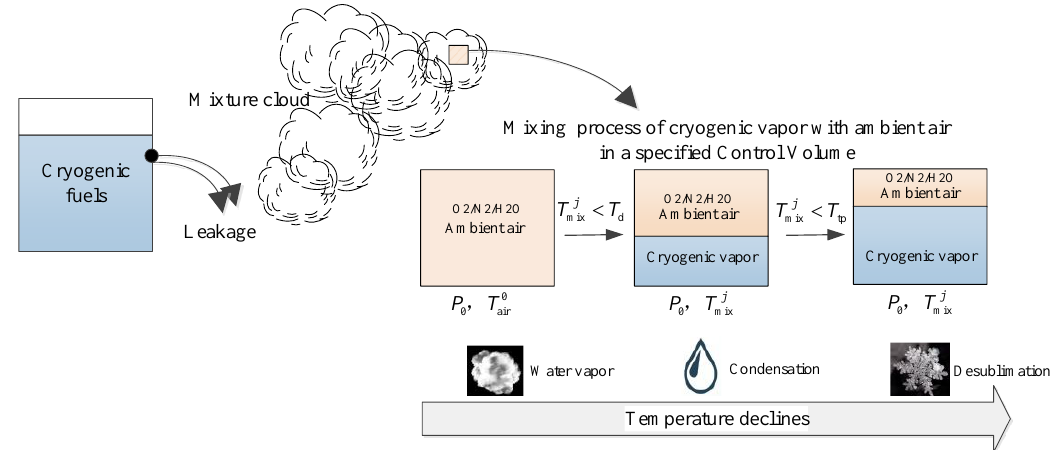
Figure 1. Schematic of water vapor phase change when cryogenic fuels leak.